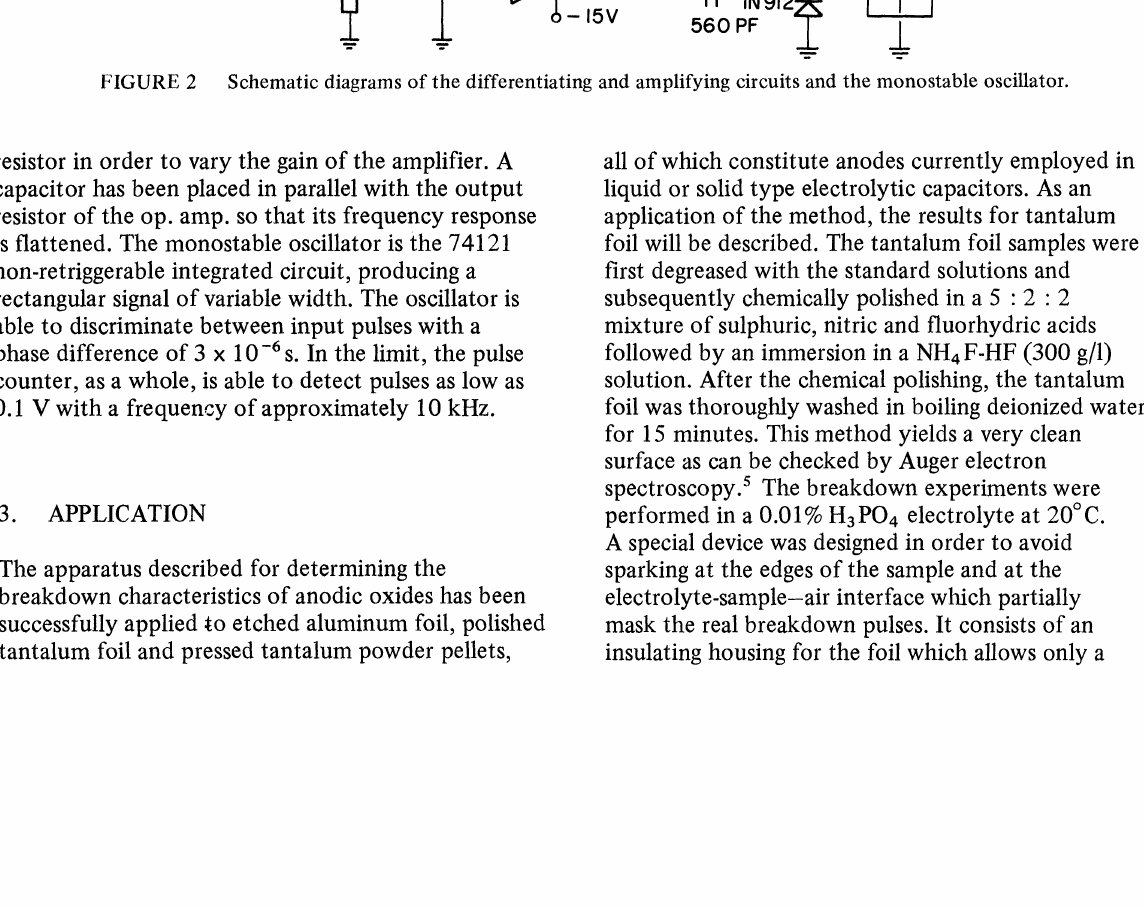
FIGURE Block diagram of the electronic system for counting the breakdown pulses. The signal at each stage is also shown. RECORDER